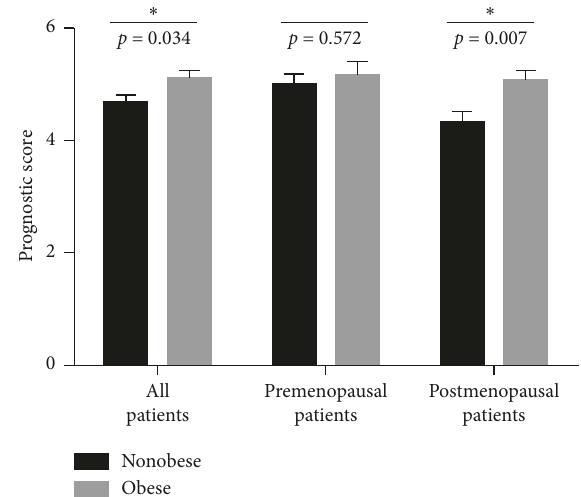
Figure 2: Association of obesity with prognostic scores in breast cancer patients at time of diagnosis. Bars represent mean prog- nostic score value SEM. Statistical significance at P 0 . 05. ∗ ± < Table 5: Multivariate logistic stepwise regression analysis of factors predictive of disease recurrence and death in breast cancer patients. 95% confidence Outcomes/predictors Odds ratio limits P value Lower Upper Recurrence BMI